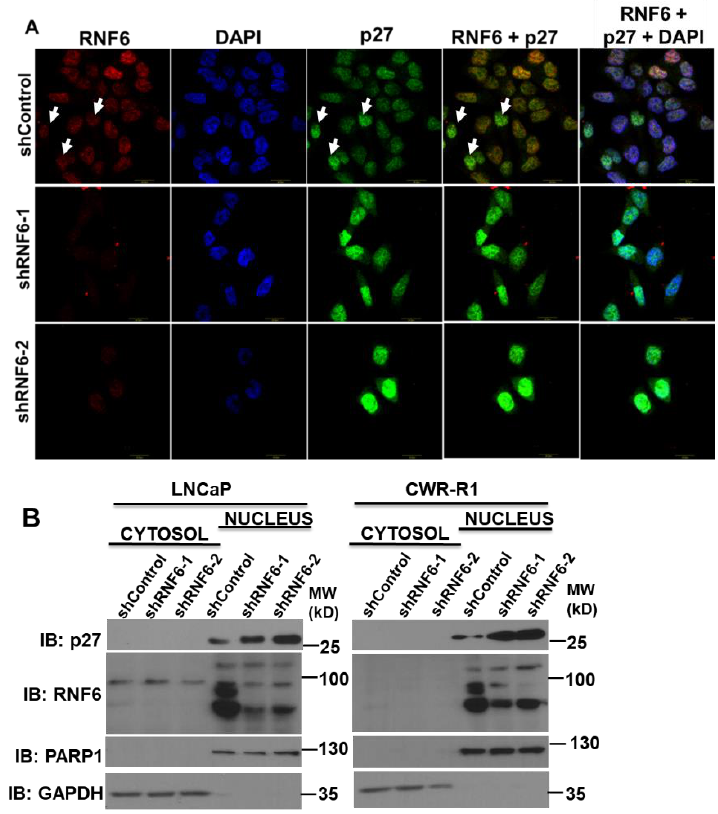
Figure 3. RNF6 knockdown leads to increase in p27 levels in the nucleus. ( A ) CWR-R1 cells were transduced with either control shRNA or shRNF6. After 72 h, cells were fixed, and immunofluores- cence confocal microscopy was carried out on the cells by co-staining with anti-p27 (green) and anti- RNF6 (red) antibodies. Cells were counterstained with DAPI. ( B ) LNCaP/CWR-R1 cells were trans- duced with either control shRNA or shRNF6. After about 72 h of transduction, cells were fraction- ated as described in the Materials and Methods. The cytosolic and nuclear fractions were then sub- jected to Western blot analysis.